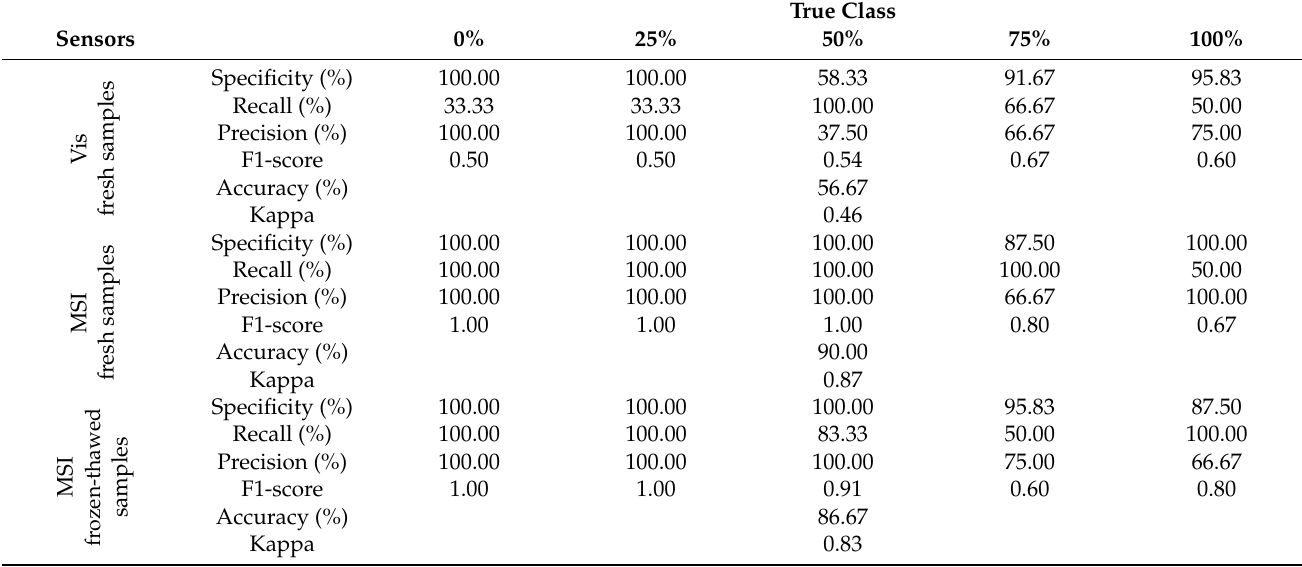
Table 1. Specificity, recall, precision, F1-score, accuracy and kappa for the classification of SVMs for the external validation ( n = 30) of fresh samples using Vis and MSI data and of frozen-thawed samples using MSI data considering five